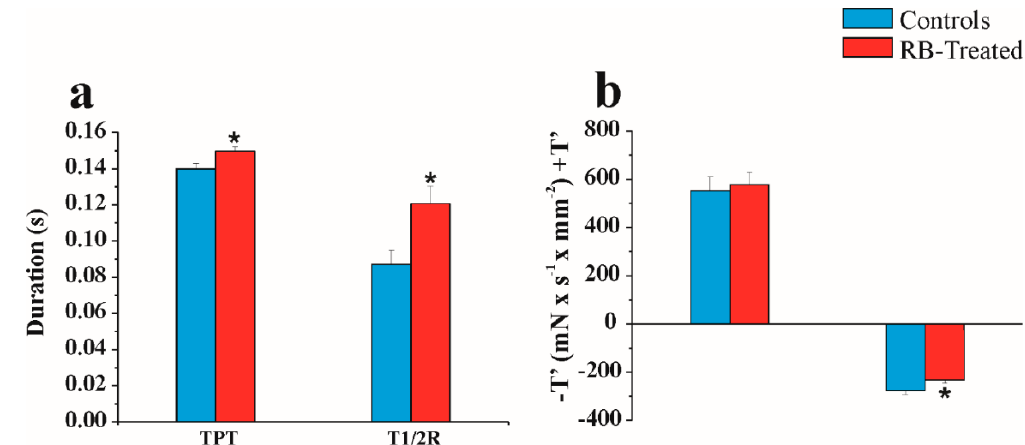
Figure 6. Isometric contractility indices in controls and RB-treated LVPMs. ( a ) TPT, time to peak tension, and T ½ R, half-time of relaxation. ( b ) +T’, peak rate of tension rise, and − T’, peak rate of tension fall. Values are expressed as the mean ± SEM; * p < 0.05. Statistical analysis: Student’s t -test.